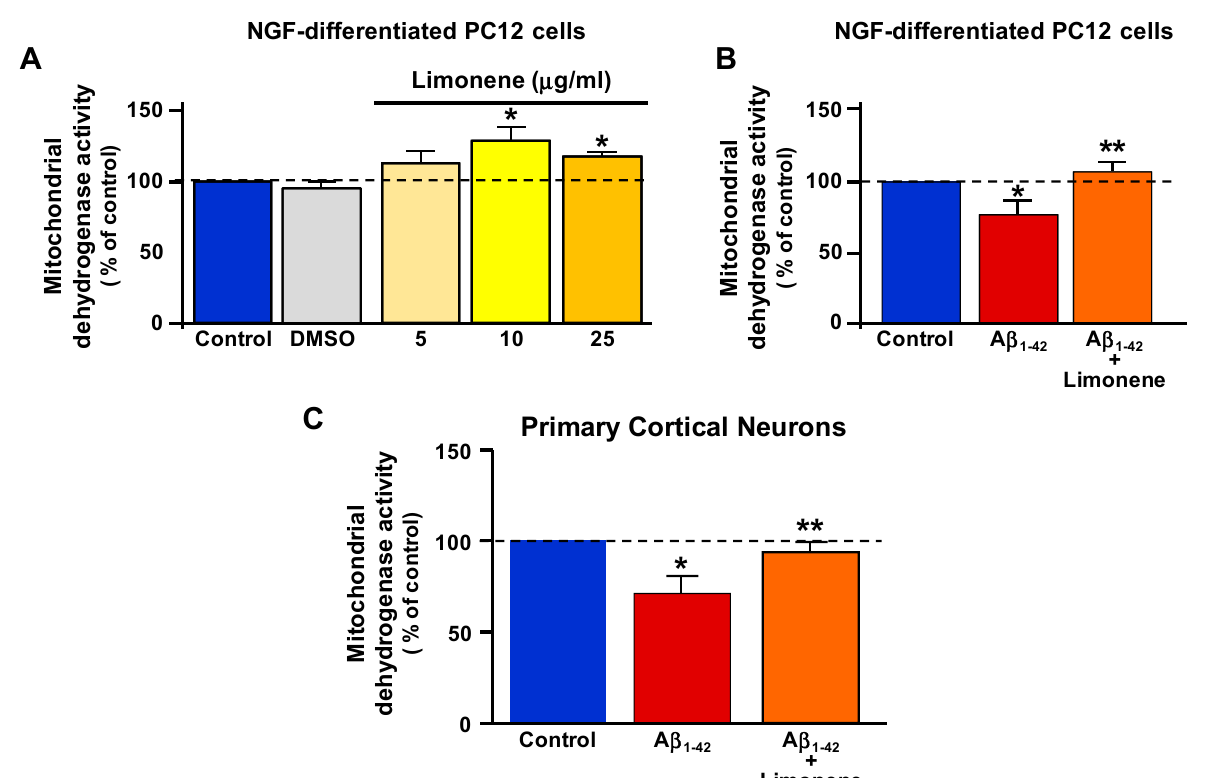
Figure 1. Effects of limonene on mitochondrial dehydrogenase activity in NGF-differentiated PC12 cells and primary cortical neurons exposed to A β 1-42 oligomers. ( A ) Evaluation of the mitochondrial dehydrogenase activity by MTT assay in NGF-differentiated PC12 cells exposed to limonene at different concentrations (5, 10, and 25 µg/mL) for 24 h. ( B , C ) Quantification of mitochondrial dehydrogenase activity assessed by MTT assay in NGF-differentiated PC12 cells ( B ) and primary cortical neurons ( C ) exposed to A β 1-42 oligomers (5 µM/24 h) in the presence and in absence of limonene (10 µg/mL, 30 min pre-treatment). Data are shown as percentage of mitochondrial dehydrogenase activity (compared to control cells) and values are expressed as mean ± SEM of three independent experimental sessions (* p < 0.05 vs control; ** p < 0.05 vs A β 1-42 ).